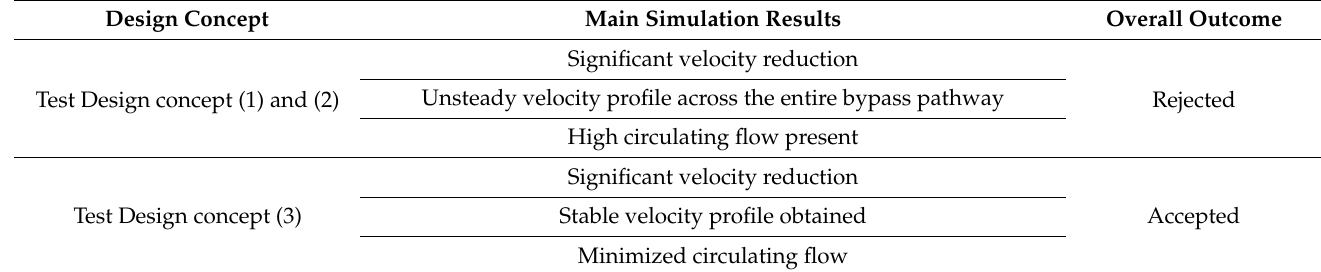
Figure 5. ( a ) Test design concept (3) 3D, mid-section; ( b ) test design concept (3) simulation result. Table 1. Test design concepts. Table 1. Test design